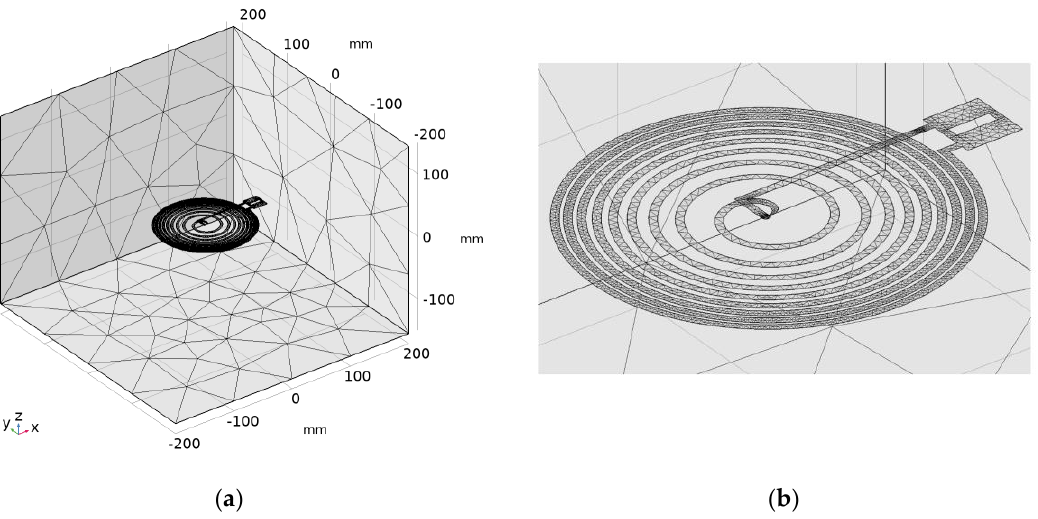
Figure 3. The finite-element mesh synthesized as a result of triangulation of the geometric model: ( a ) placement in the air cube, ( b ) detailed view of the antenna.